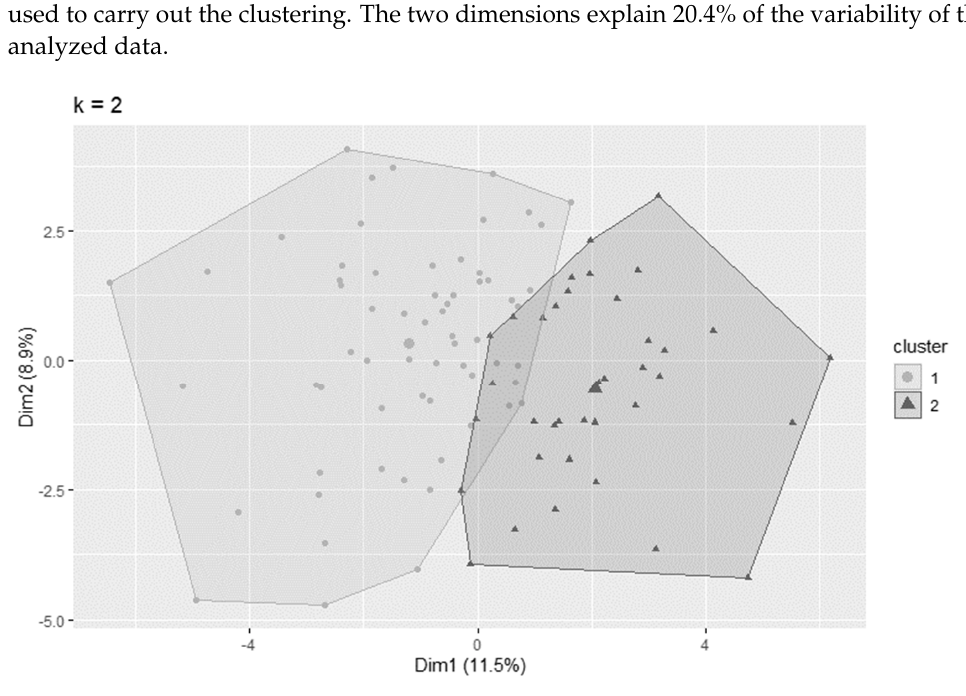
Figure 1. Cluster analysis of older adult drivers with the K − Means algorithm.